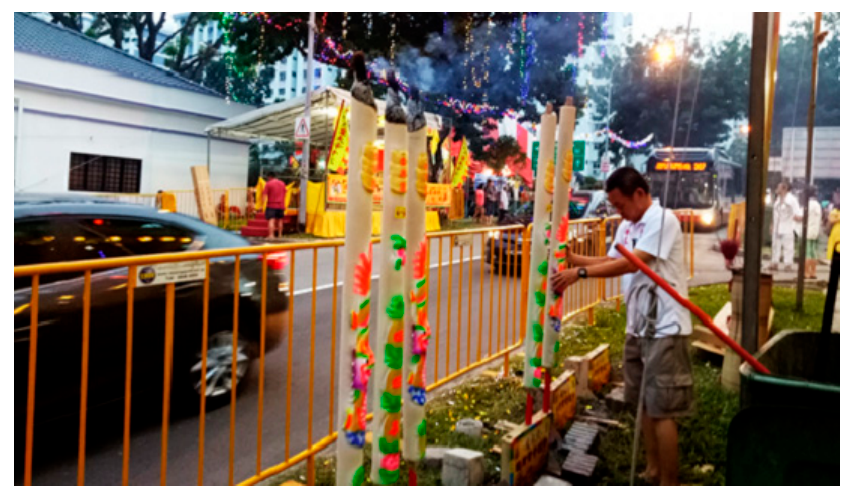
Figure 1. Ah Q sets up the giant joss sticks.